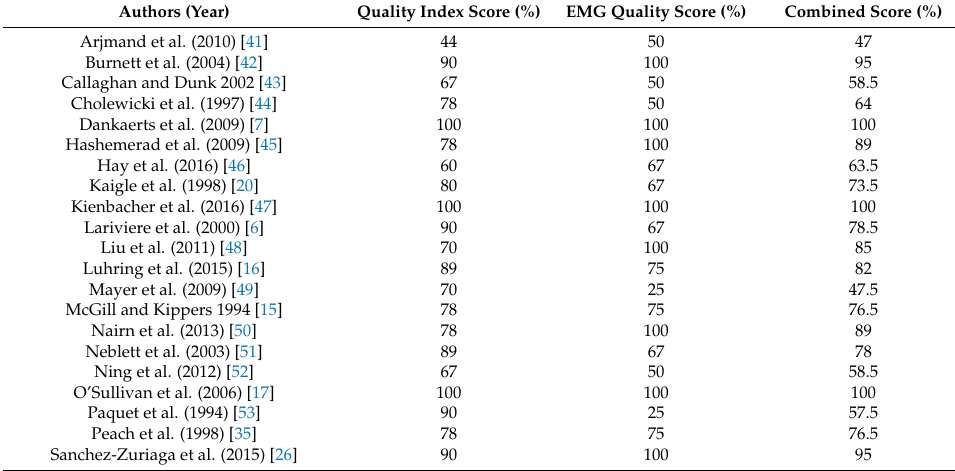
Table 3. Combined quality index and EMG quality